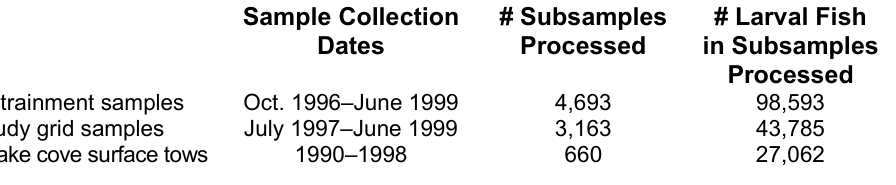
Collection Period, Number of Subsamples Laboratory Processed, and Number of Larval Fish Found During the DCPP 316(b)